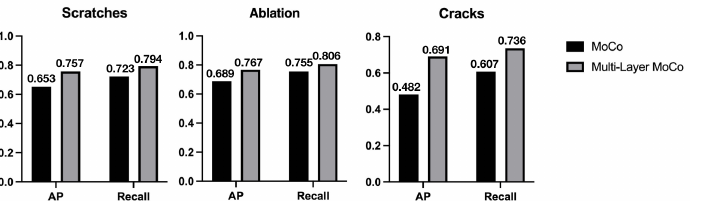
Figure 7. Comparison of experimental results between the multi-layer MoCo method and the MoCo method for the swirler dataset.